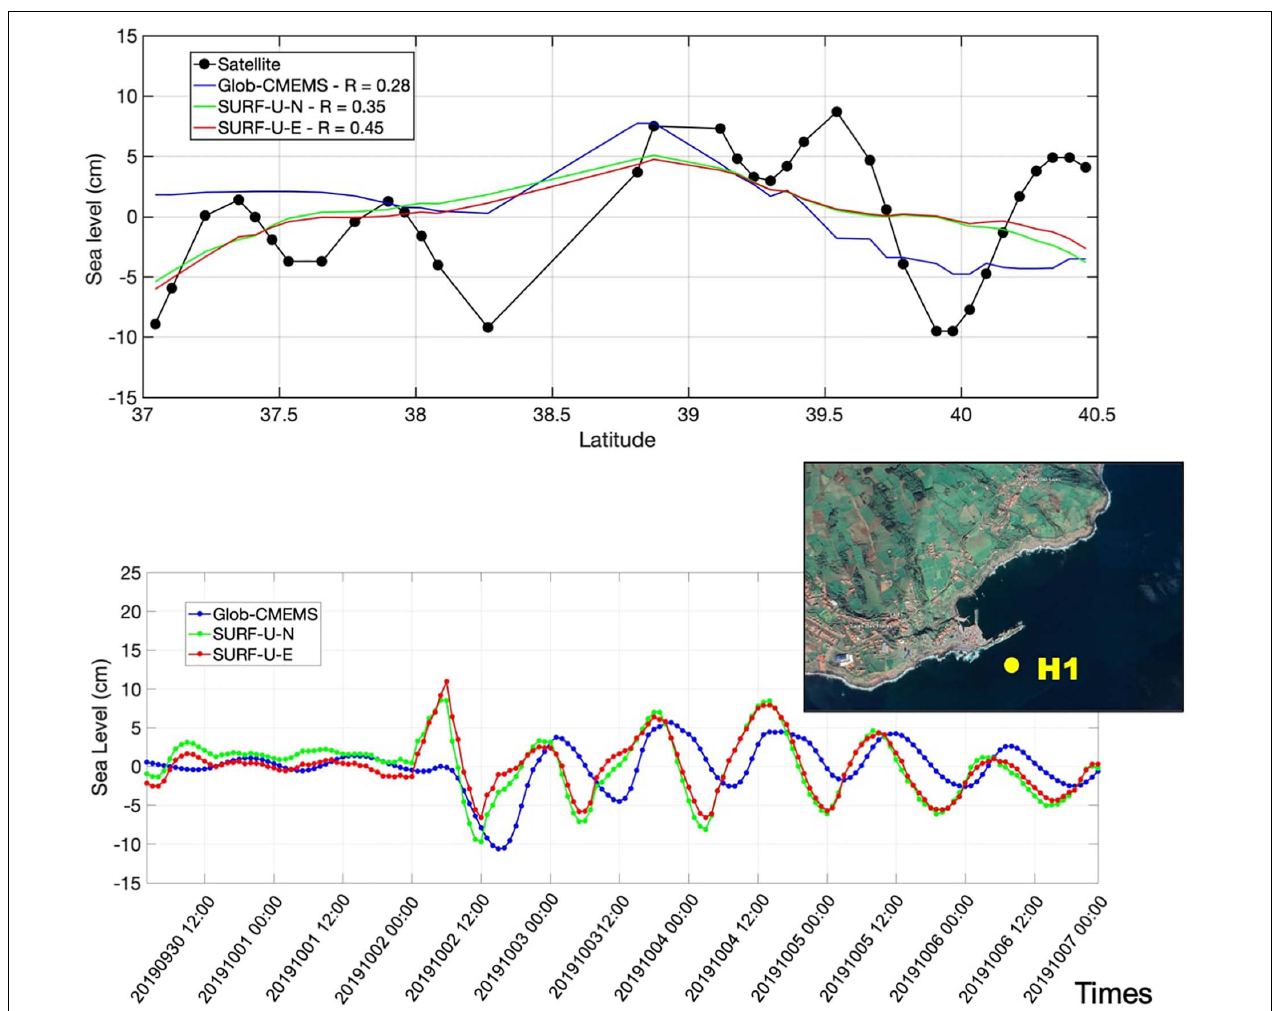
FIGURE 7 | Comparison between the satellite absolute dynamic topography and the sea surface height from the CMEMS and the two SURF-U models ( top panel ). The time series of the sea level for Glob-CMEMS, SURF-U-N, and SURF-U-E close to the commercial port of Lajes in Flores (bottom panel) are